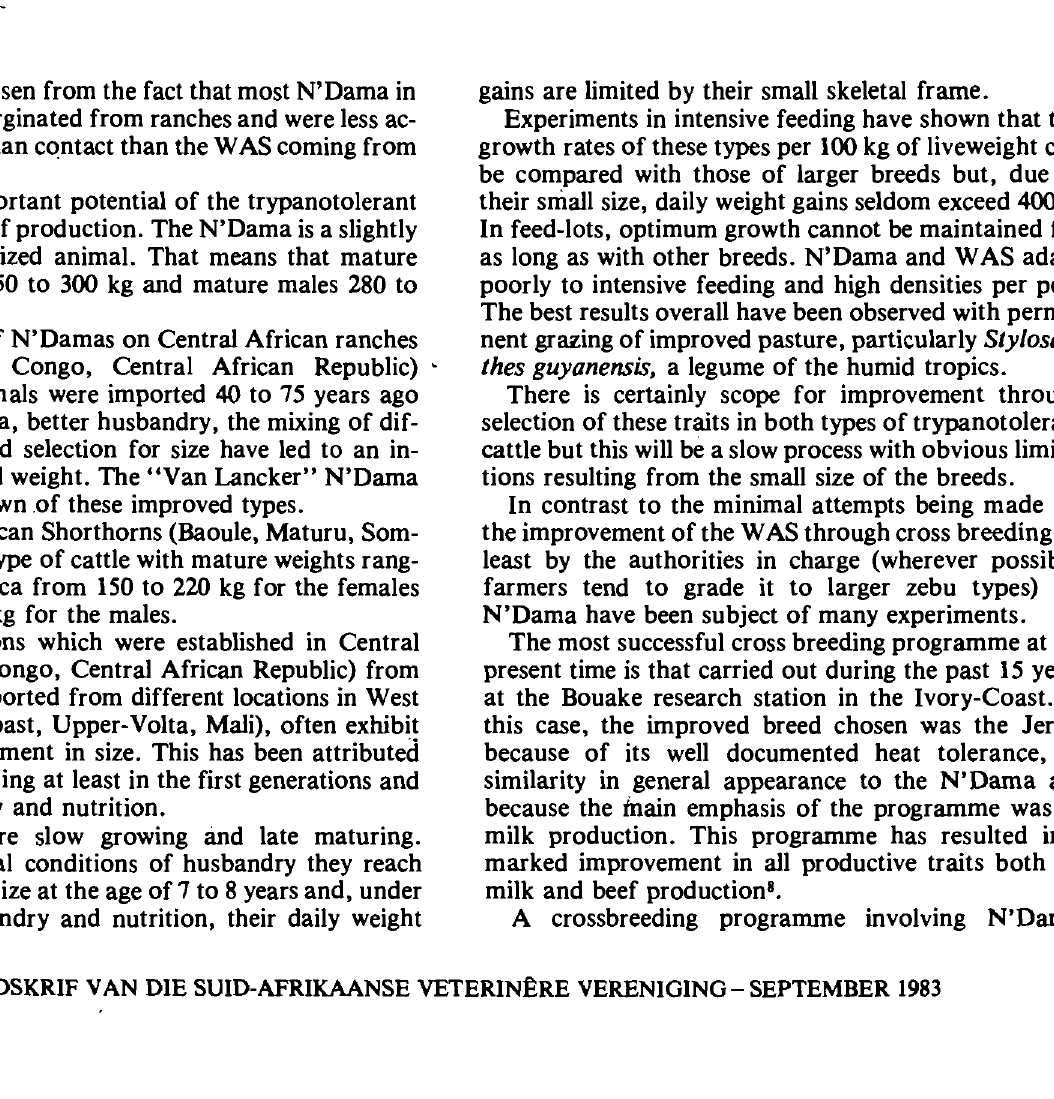
Table 2: GROWTH PERFORMANCE OF TRYPANOTOLERANT CATILE (WEIGHT IN kg) Age